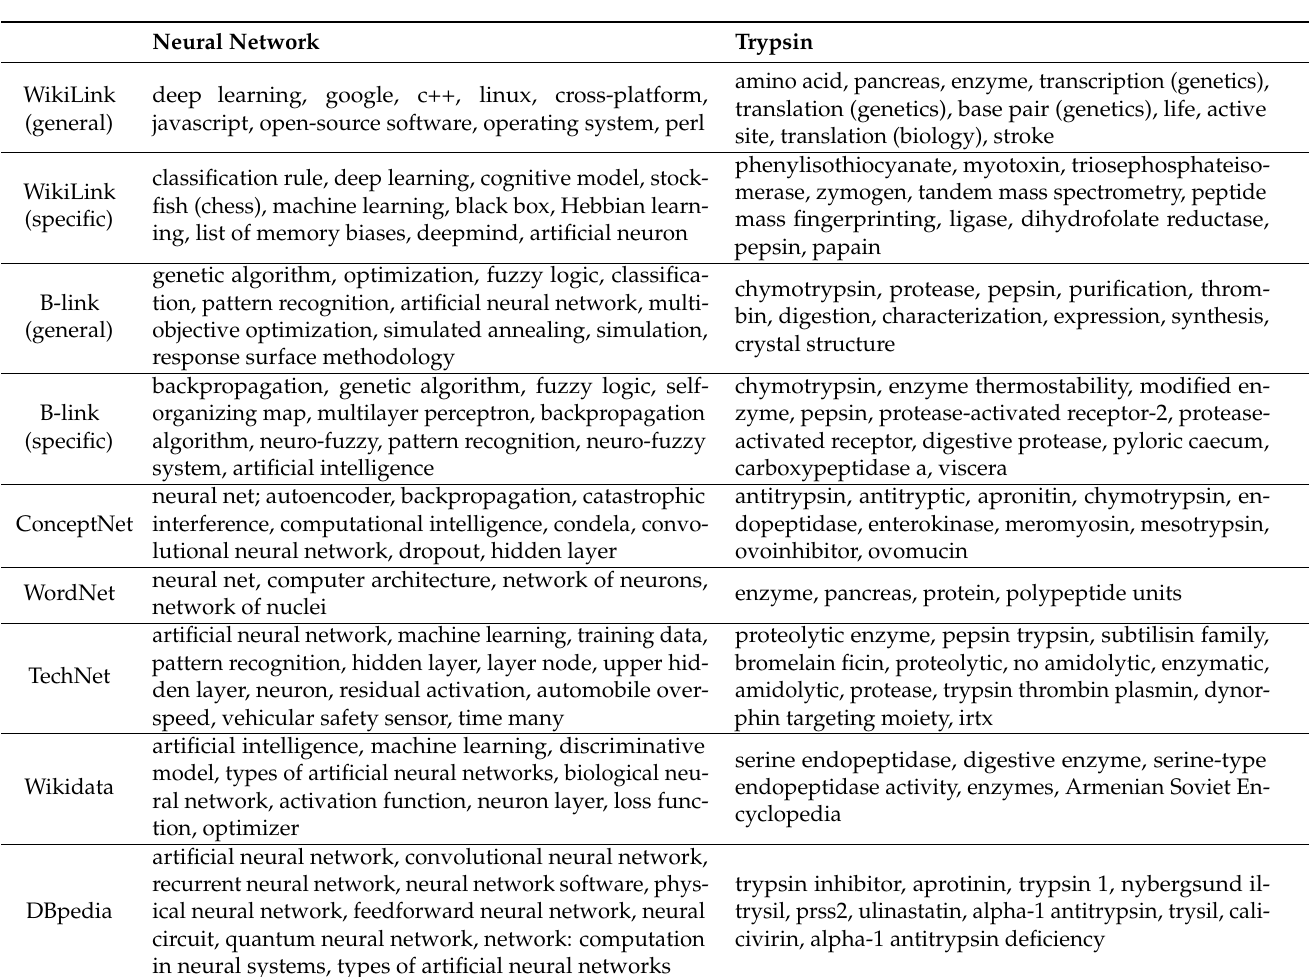
Table 9. The top 10 related terms to “neural network” and “trypsin” in WikiLink and the 4 benchmark